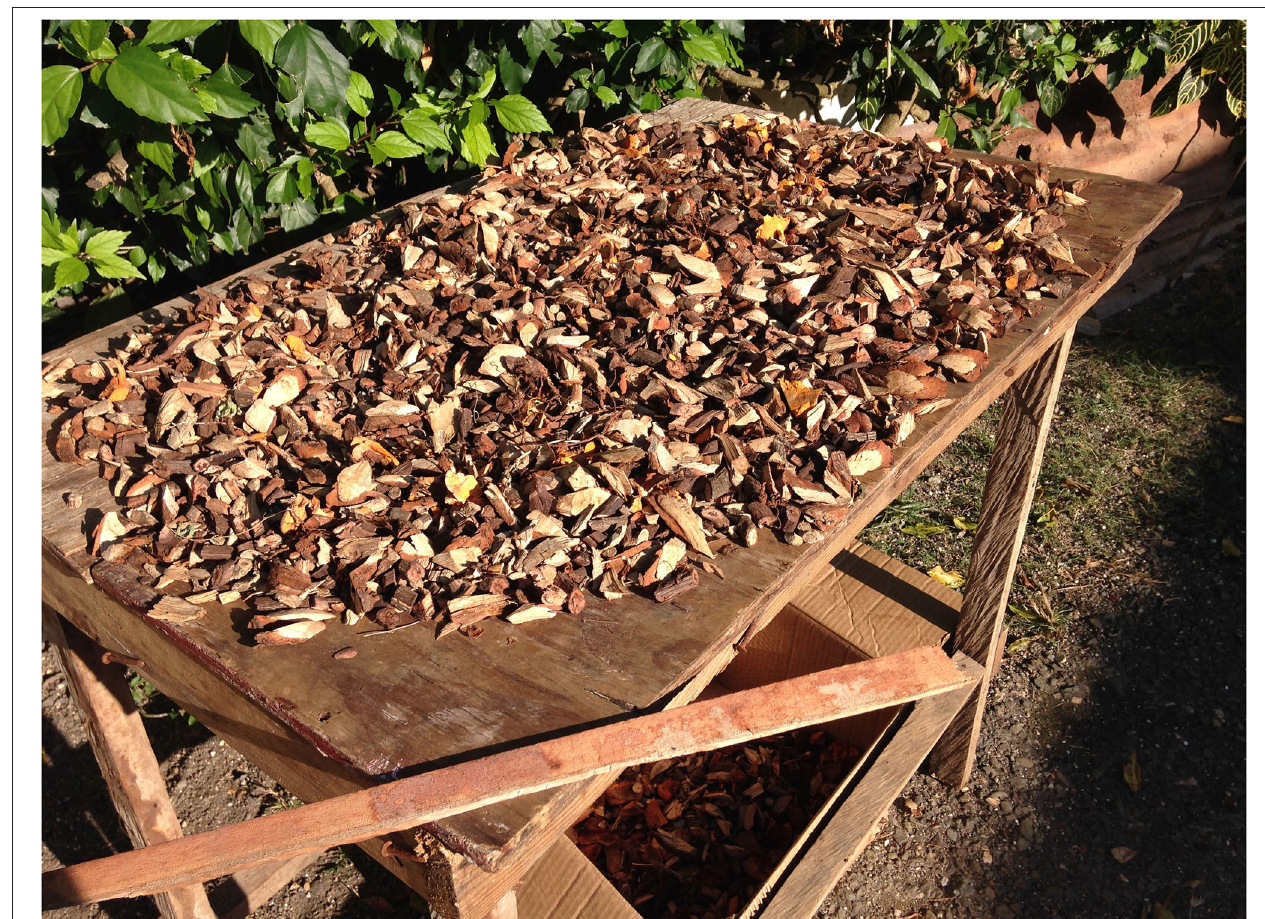
FIGURE 3 | Roots and bark are chopped and dried naturally in the sun (photo credit